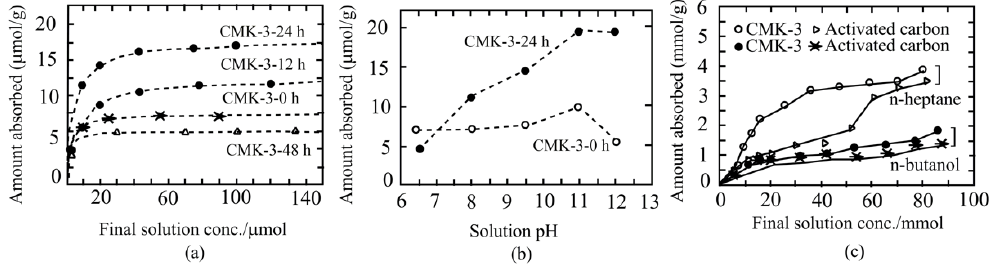
Figure 3. Adsorption of lysozyme and vitamin E over mesoporous carbon surfaces. Lysozyme adsorption dependency on the APS concentration and oxidation times, and pH of the solution ( a , b ). Comparative analyses of lysozyme adsorption on various forms of activated carbons ( a ) and dependency of pH on the adsorption properties of lysozyme enzyme ( b ), adapted with permission from [57]. Adsorption ability of vitamin E onto carbon surfaces from n-heptane and n-butanol at 293 K ( c ), adapted with permission from [58].